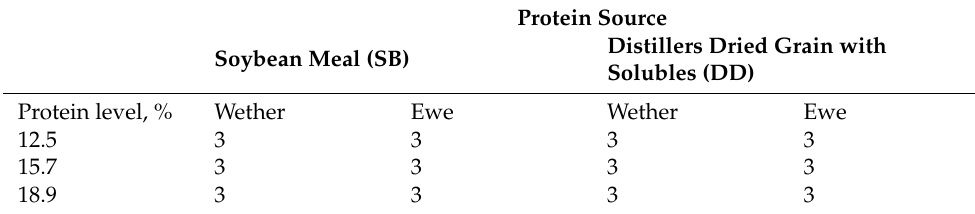
Table 1. Experimental